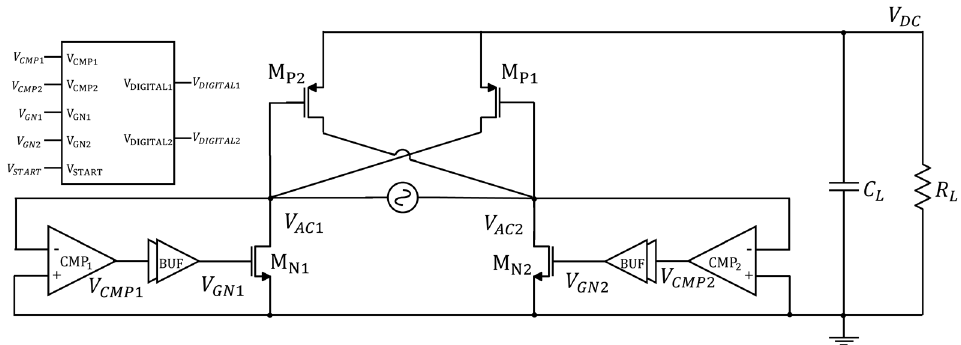
Figure 5. The implementation of the proposed active rectifier.